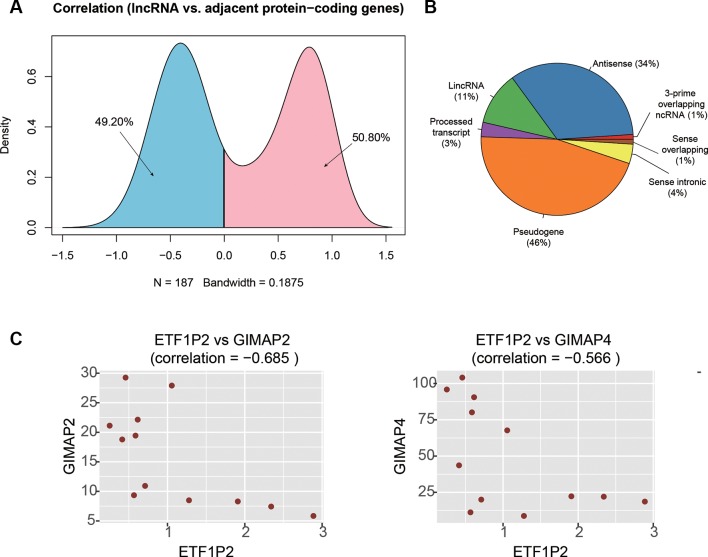
The cis-acting lncRNA candidates involved in AF. (A) The density of the correlation coefficients between lncRNAs and the corresponding adjacent PCGs. (B) The distribution of RNA biotypes for the cis-acting lnRNA candidates. (C) The correlation coefficients between ETF1P2 and GIMAP2, and between ETF1P2 and GIMAP4.